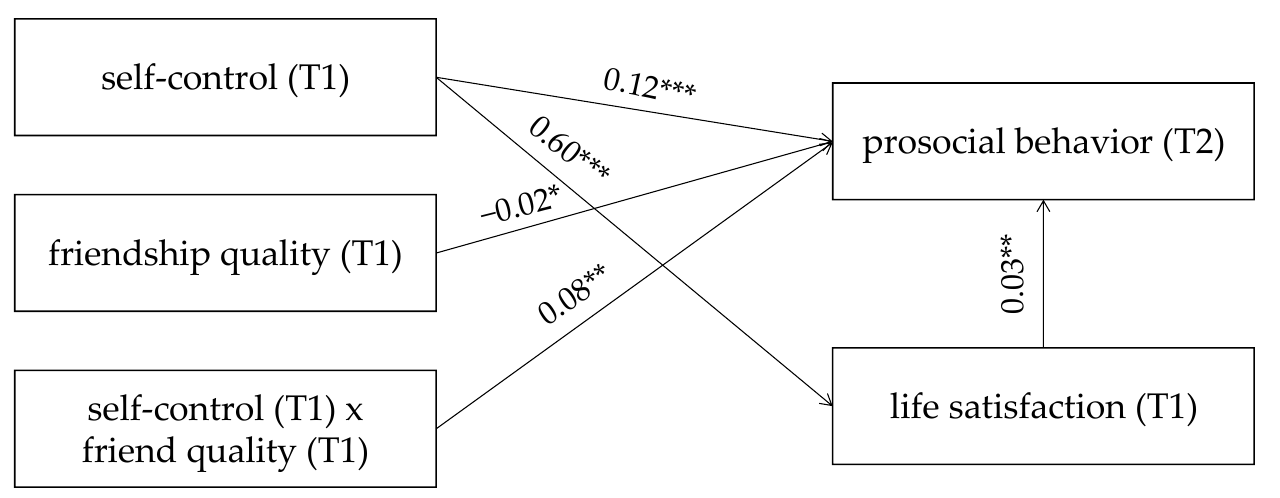
Figure 3. Model of the moderating role of friendship quality in the indirect relationship between self-control and prosocial behavior. (T1) represents this score obtained at T1. (T2) represents this score obtained at T2. Note: * p < 0.05, ** p < 0.01, *** p < 0.001.